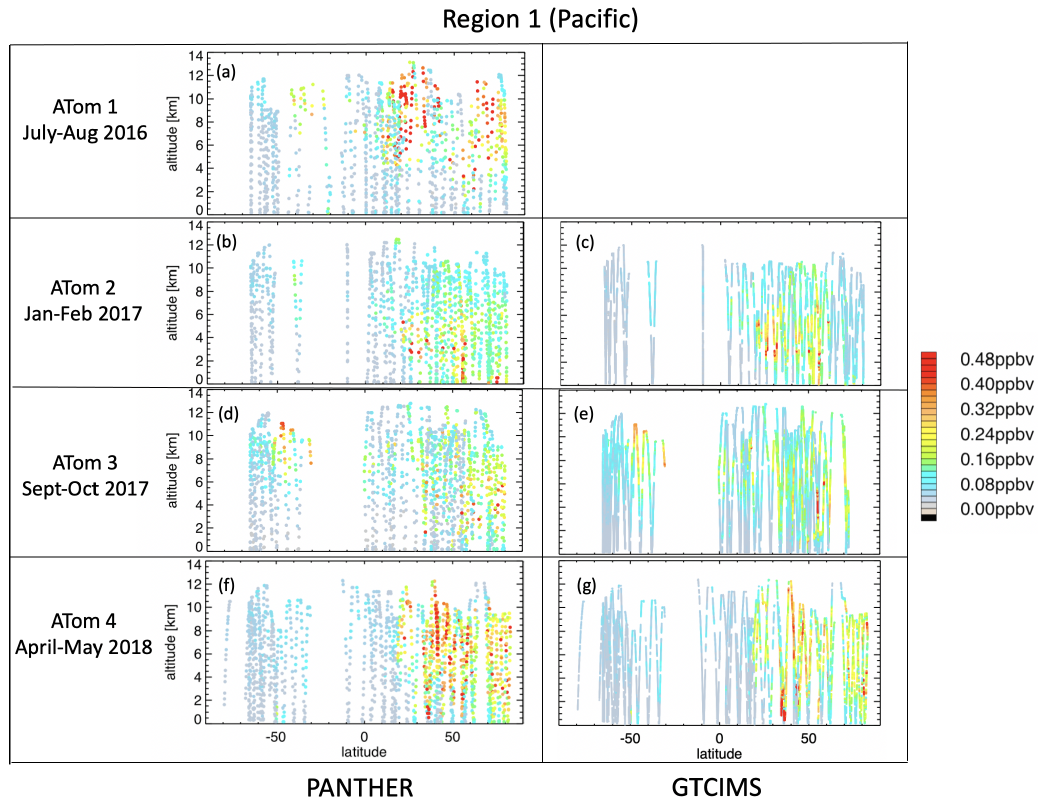
Figure 2. Aircraft measurements of PAN from PANTHER (a, b, d, f) and GTCIMS (c, e, g) instruments from ATom-1, ATom-2, ATom-3 and ATom-4 for Region 1 (Pacific, longitude less than − 60 ◦